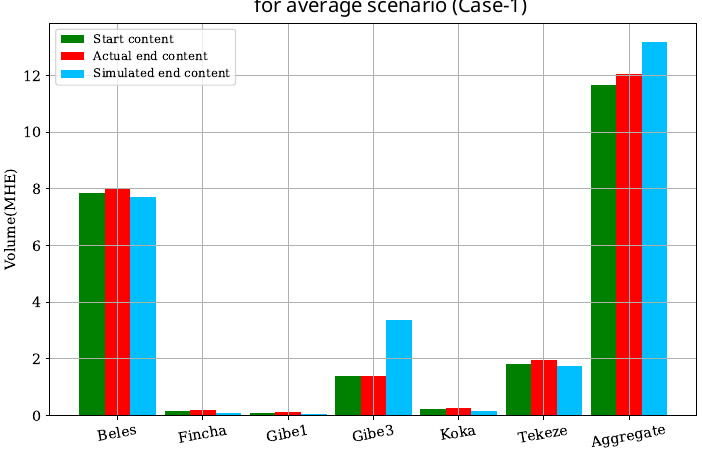
Figure 14. Start and final reservoir contents for the actual operation and simulation of case 1.